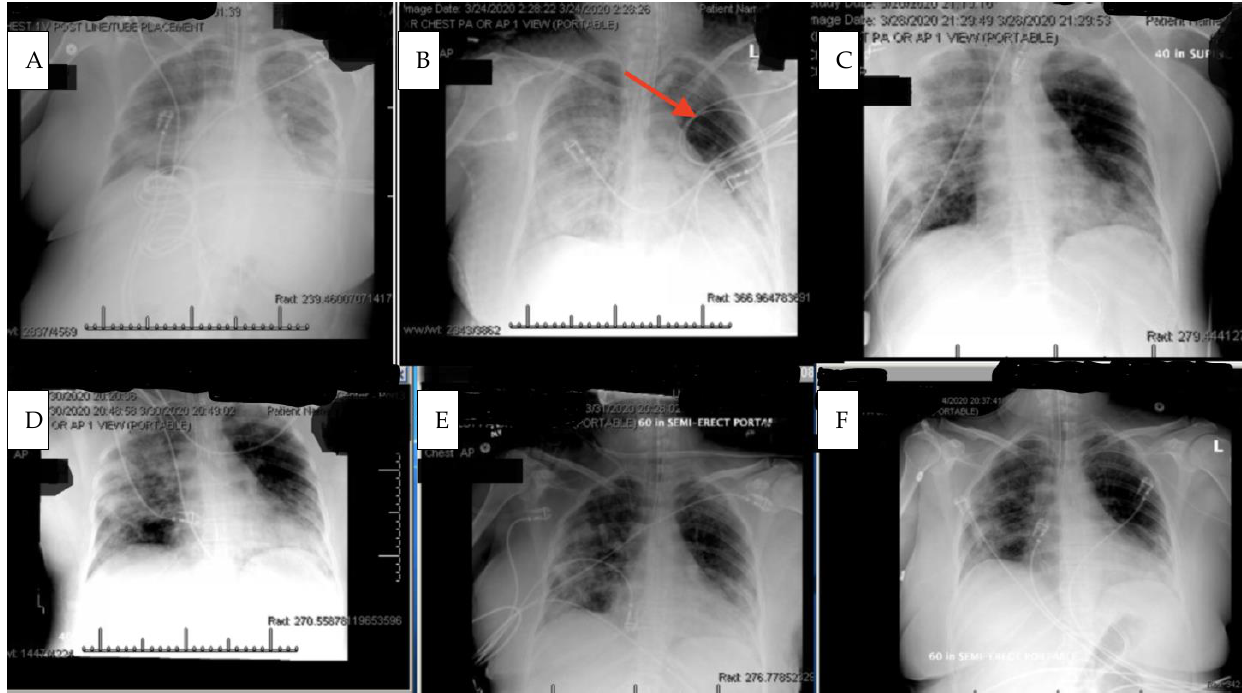
Figure 2. Chest X rays prior to and during eculizumab therapy. ( A ): Chest X ray taken 22 h prior to first dose of eculizumab deonstrates bilateral extensive pulmonary infiltration consistent with Covid-19 related Adult Respiratory Distress Syndrome. ( B ): four hours after the first eculizumab dose (red arrow denotes area of improved aeration). ( C ): Following the second dose of eculizumab. ( D ): Following the third dose of eculizumab. ( E ): Following the fourth dose of eculizumab. ( F ): Extubation.